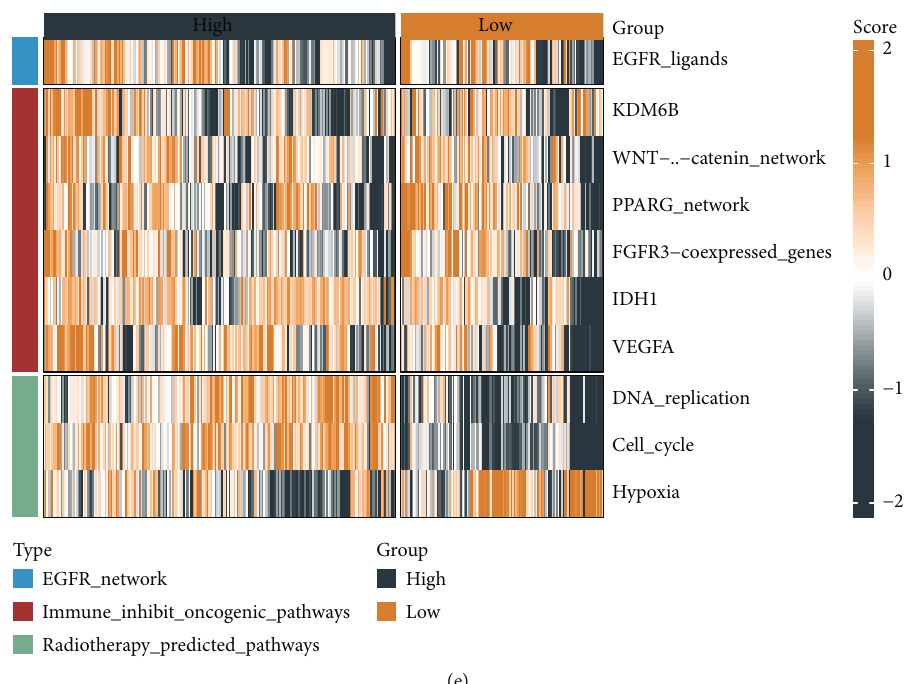
Figure 6: NCAPG immune signature analysis. (a) Correlation between NCAPG and pan-cancer T cell in fl ammation scores. (b) Pearson correlation analysis between NCAPG and immune checkpoints (X represents P > 0 : 05 ). (c) Correlation between NCAPG and molecular subtypes and features of STAD using seven di ff erent algorithms. (d) Mutational pro fi les of genes associated with neoadjuvant chemotherapy between low and high NCAPG groups. (e) Correlation between NCAPG and enrichment scores for several treatment features including targeted and radiation therapies ( ∗ , P < 0 : 05 ; ∗∗ , P < 0 : 01 ; ∗∗∗ , P < 0 : 001 ; ∗∗∗∗ , P < 0 : 0001